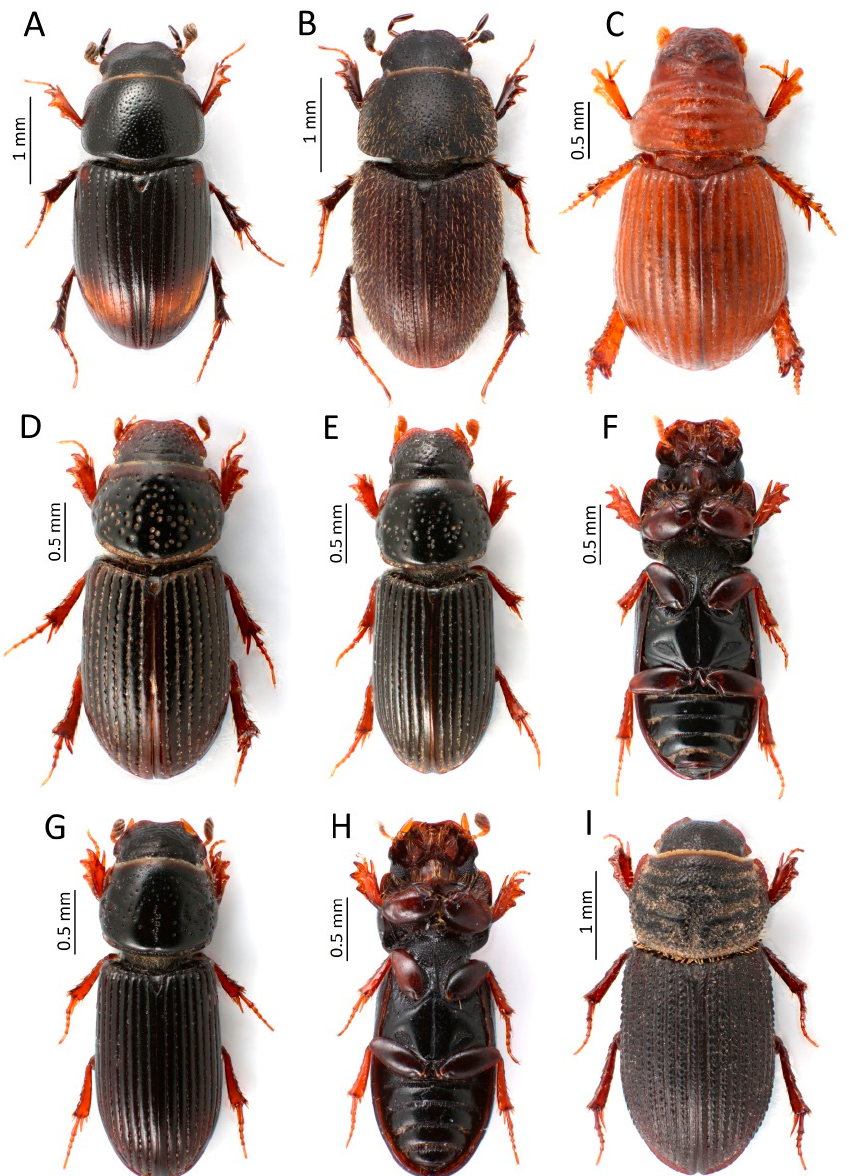
Figure 6. Rare and new species for the fauna of Montenegro recorded in the course of this study: ( A )— *Phalacronothus biguttatus , ( B )— *Trichonotulus scrofa , ( C )— *Psammodius nocturnus , ( D )— *Platytomus tibialis , ( E , F )—* Pleurophorus mediterranicus , ( G , H )— *P. pannonicus , ( I )—* Rhyssemus berytensis (*—species new for the Montenegro fauna) (Photos: Łukasz Minkina). Localities. Ri đ ani at Nikši ć , 28 May 2021, 1 ex. [MB]; Škala at Gusinje, 21 May 2021, 4